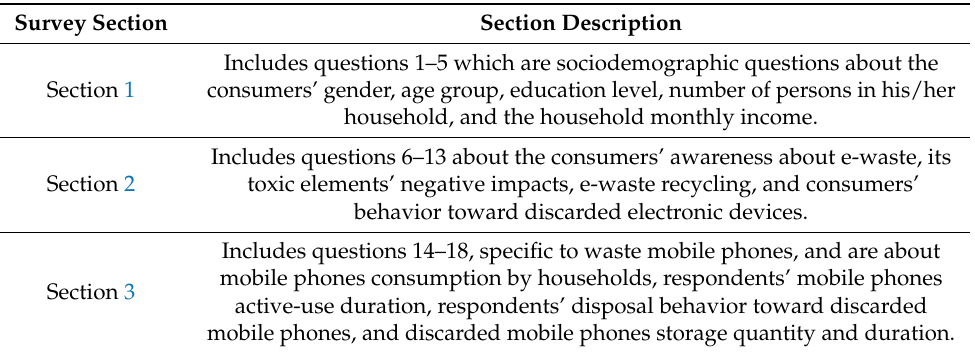
Table 3. Survey Sections General